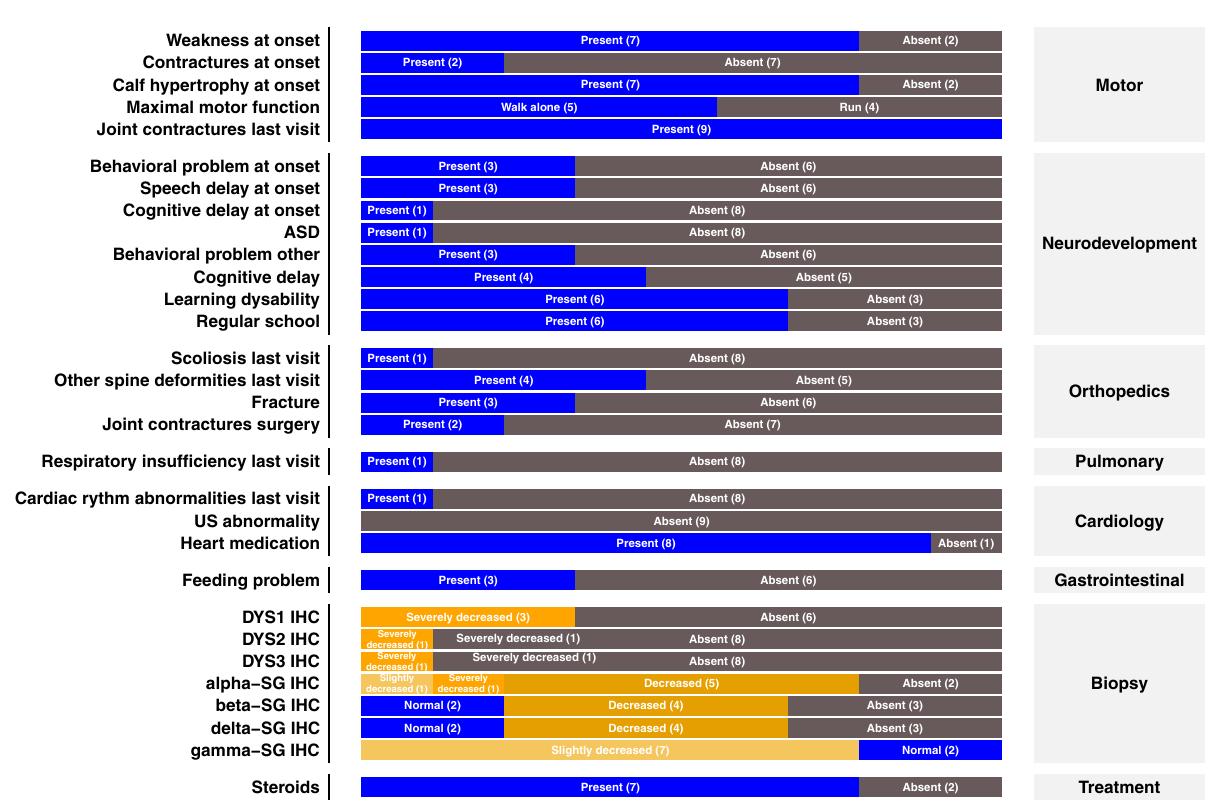
Figure 5. Clinical characteristics of DMD patients. ASD: autistic spectrum disorders, DYS: dystrophin, IHC: immunohistochemistry, US: ultrasound, SG: